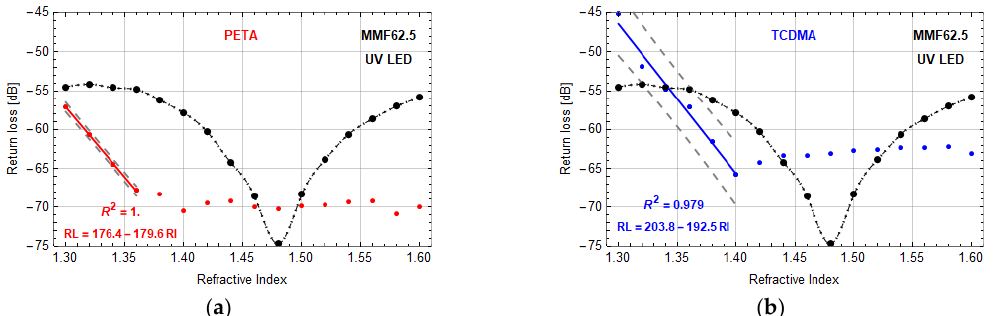
Figure 6. Return loss vs. RI—microtip manufactured by using UV LED on MMF62.5 based on polymers: ( a ) PETA, optical power 40 µW (microtip size: 61 ± 1 µm base diameter), ( b ) TCDMA, optical power 30 µW (microtip size: 58 ± 1 µm base diameter). Manufacturing parameter: exposition time—30 s. Red and blue lines are linear approximations of measurement points with presented equations and coefficient of determination R 2 . Black dots are reference measurements of the return loss of MMF62.5 without microtip.